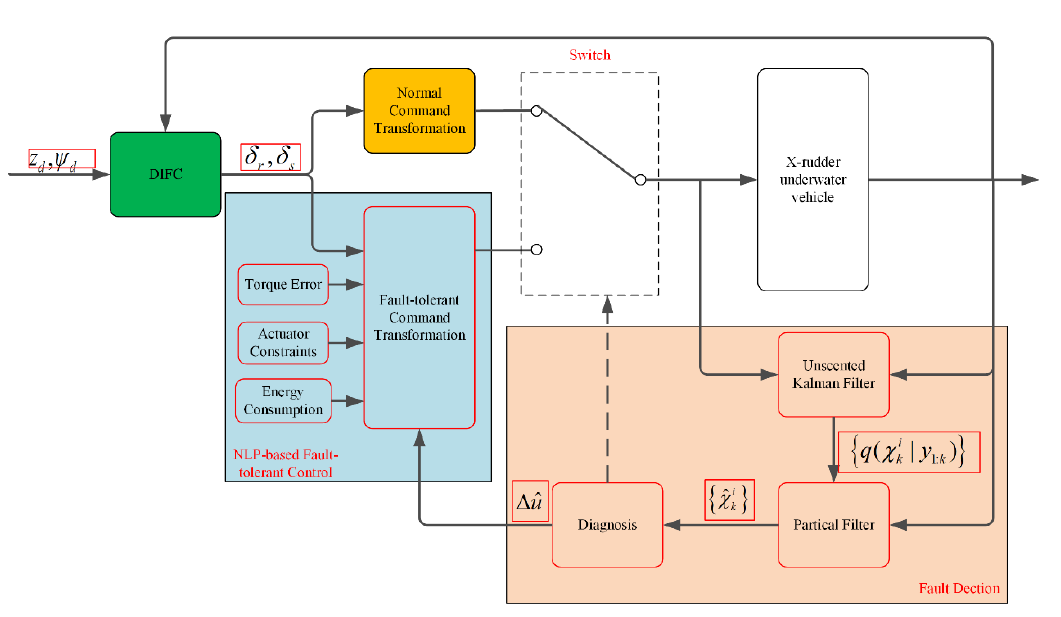
Figure 10 . Control block diagram of fault-tolerant steering prototype. Figure 10. Control block diagram of fault-tolerant steering